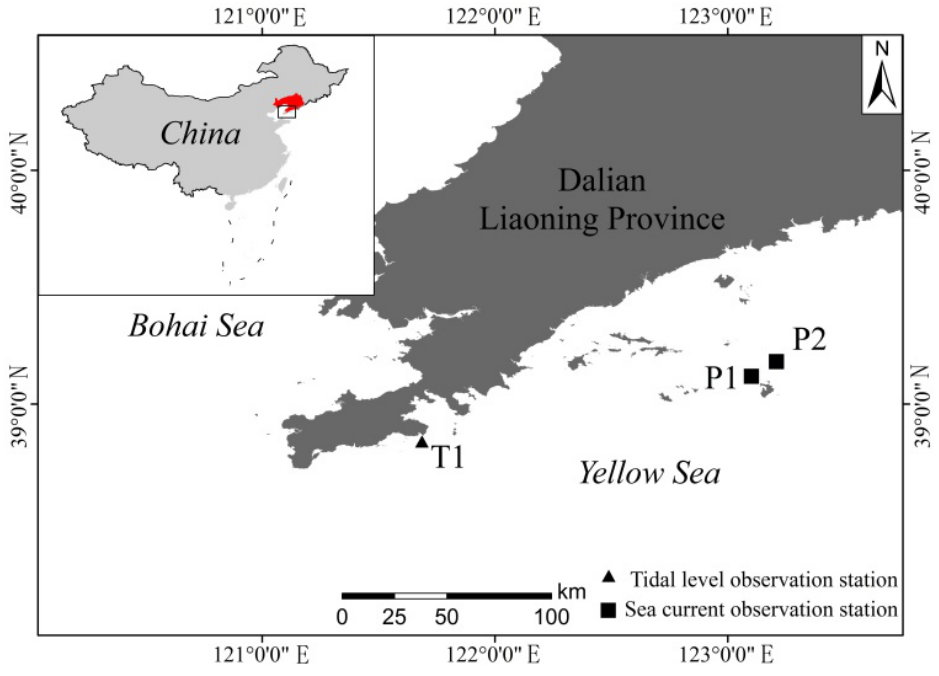
Figure 2. Locations of the observation stations.